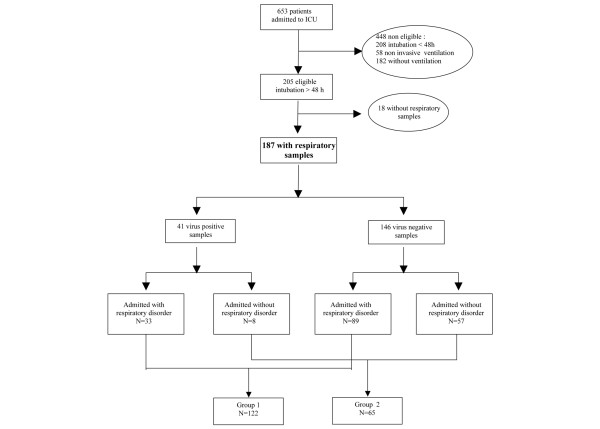
Profile of the study. ICU, intensive care unit.